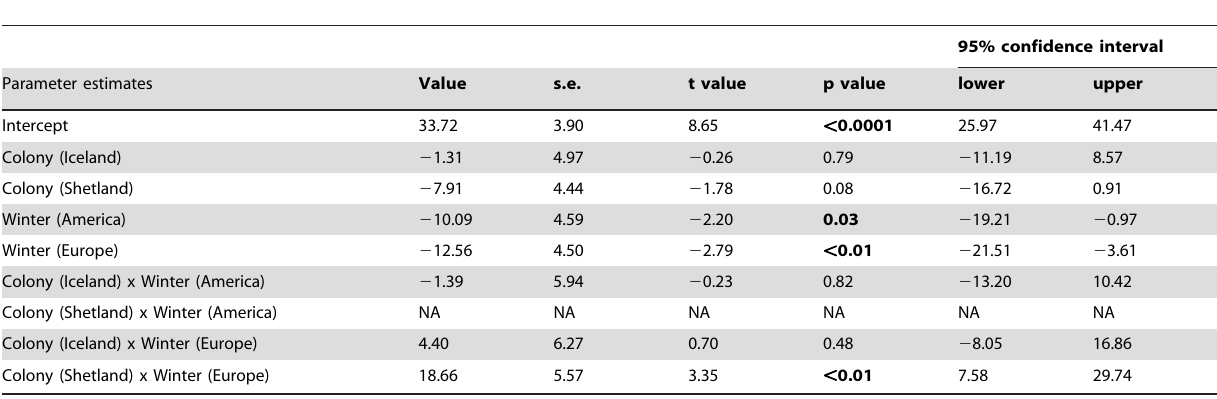
Table 1. Parameter estimates for type III general linear model (GLM) assessing the influence of wintering area (i.e., Africa, America and Europe) and breeding colony (i.e., Bjørnøya, Iceland and Shetland) on feather corticosterone levels of breeding great skua ( Stercorarius skua